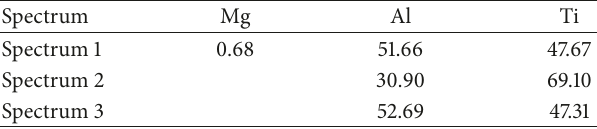
Table 5: Chemical composition measured in Spectrums 1 to